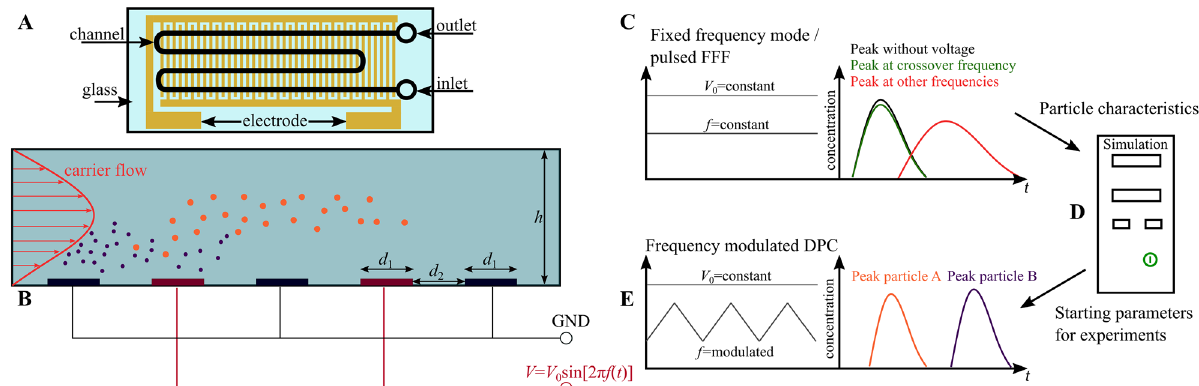
Figure 1. ( A ) Top view of the microfluidic device (sketch). ( B ) The microfluidic separation column (side view, height h = 80 µ m and electrode width/spacing d 1 = d 2 = 100 µ m ) is continuously flushed with a carrier fluid. Once per experiment a particle suspension is injected. The device is used for two different types of experiment. (I) The crossover frequency of particles is determined using field-flow fractionation (FFF) at a fixed frequency f by comparing the elution profiles with and without applied voltage ( V 0 ) ( C ). The obtained particle characteristics where used as input parameters for a full-scale simulation model realized in COMSOL Multiphysics to find suitable process parameters ( D ). (II) Eventually, the set of process parameters is used as starting point for experiments to achieve a chromatographic separation by using frequency-modulated ( f = f ( t ) ) dielectrophoretic particle chromatography (DPC) ( E